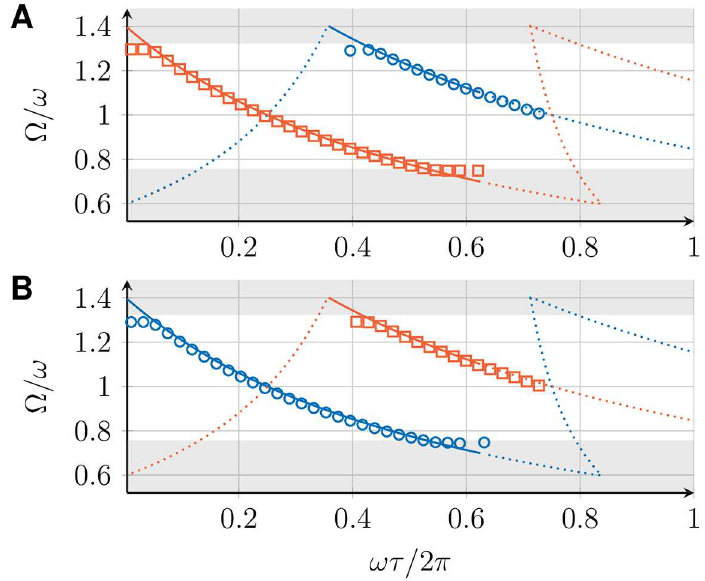
Fig 10. Experimental measurements of the collective frequencies Ω for two coupled DPLLs. Collective frequency Ω of the in-phase(blue circles) and checkerboard synchronizedstate (red squares) for two mutually coupledDPLLs as a function of the transmission delay τ . Symbols show experimental data points. Lines show analyticalresults of the phasemodel, Eq (10), where solid blue lines denote in-phase solutionsand red lines denotecheckerboard solutions.The shaded areas display the VCO clippingregion. (A) Operationmode with signalinverter deactivated. (B) Operation mode with signal inverter activated. © 2015 IEEE. Reprinted,with permission, from IEEE Proceedings: Synchronization of mutually coupleddigital PLLs in massive MIMO systems